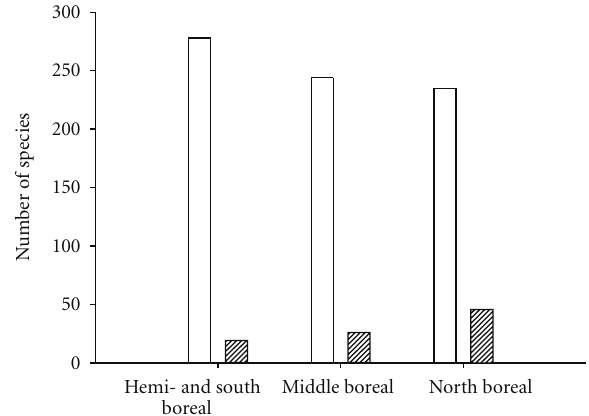
Figure 5: Pooled species richness (white bars) of crane flies (Diptera, Tipuloidea) and numbers of species not occurring in Central Europe (slashed bars) in the hemi- and south, middle, and north boreal zones. See the text for the delineation of the zones.